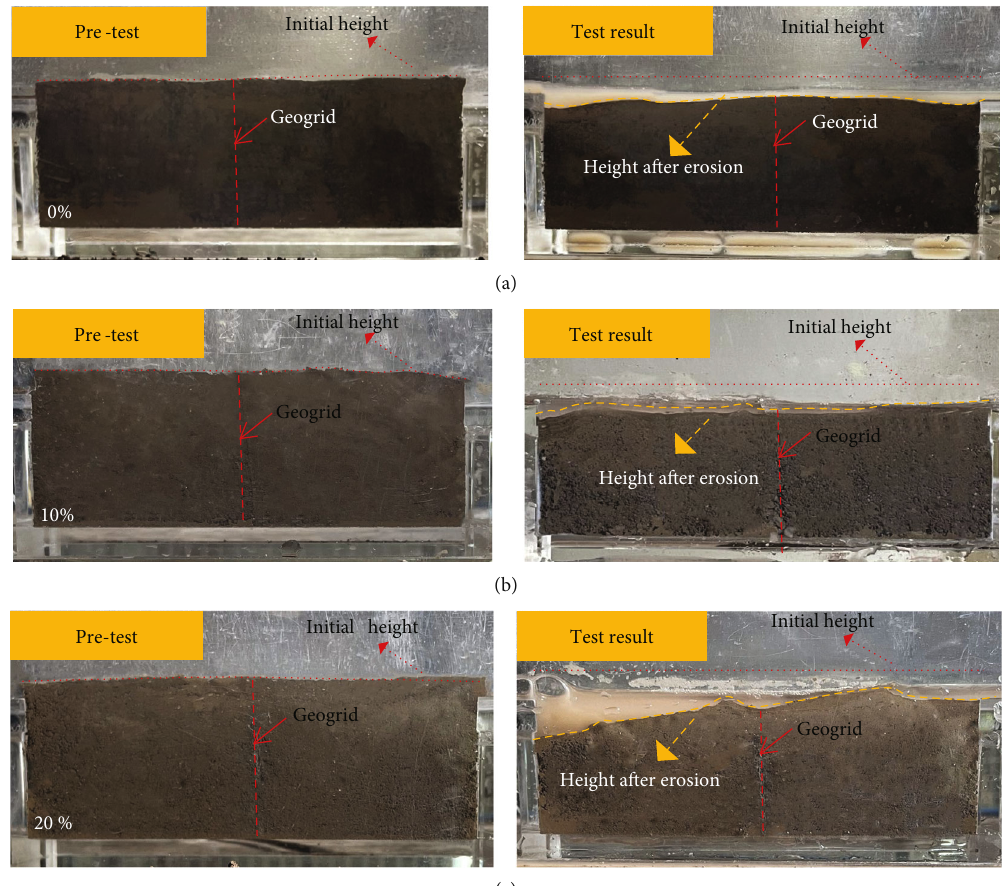
Figure 10: The erosion characterisation of the reinforced fi ne tailings specimen eroded by the mud-water mixture fl ow at the local scale for a red mud concentration of (a) 0%, (b) 10%, and (c) 20%.